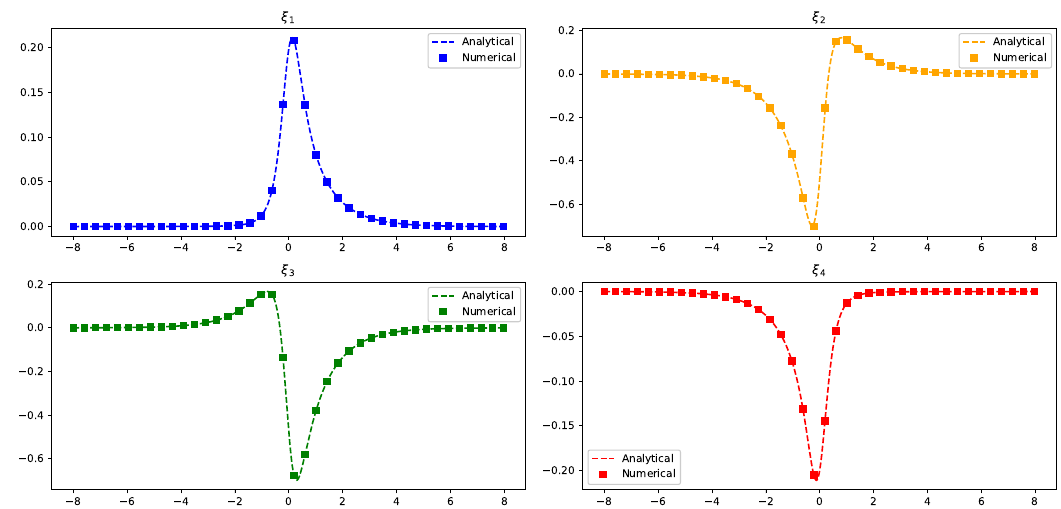
Figure 16 . The comparison of the analytical bound state components of the fermion (4.49) and the numerically simulated ones as a function of x for positive parity σ = +1 , It is hosted by the kink of figure 15. Plotted for ρ 1 = 0 . 50 , ρ 2 = 2 . 2 , θ 1 = 1 . 54 , θ 2 = 1 . 55 , κ = 1 , θ 0 = 2 π/ 3 , M = 1 . Notice that the spinor components satisfy the parity condition ξ 1 ( − x ) = − ξ 4 ( x ) and ξ 2 ( − x ) = + ξ 3 ( x ) .